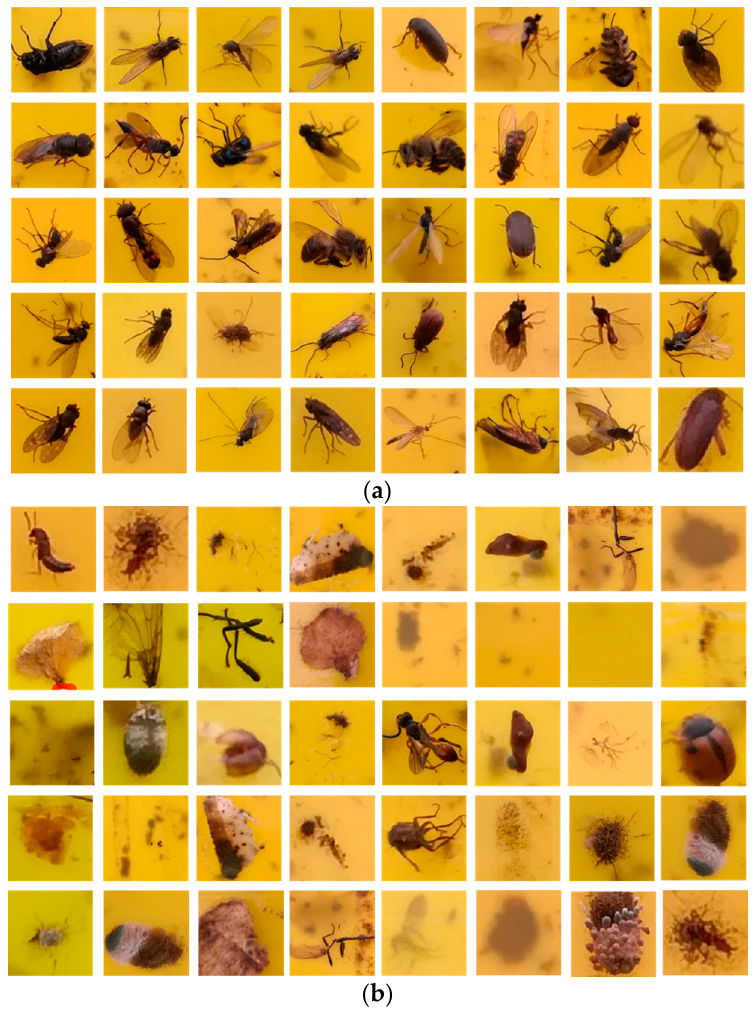
Figure 9. Positive and negative examples ( a ) Positive examples; ( b ) Negative examples.